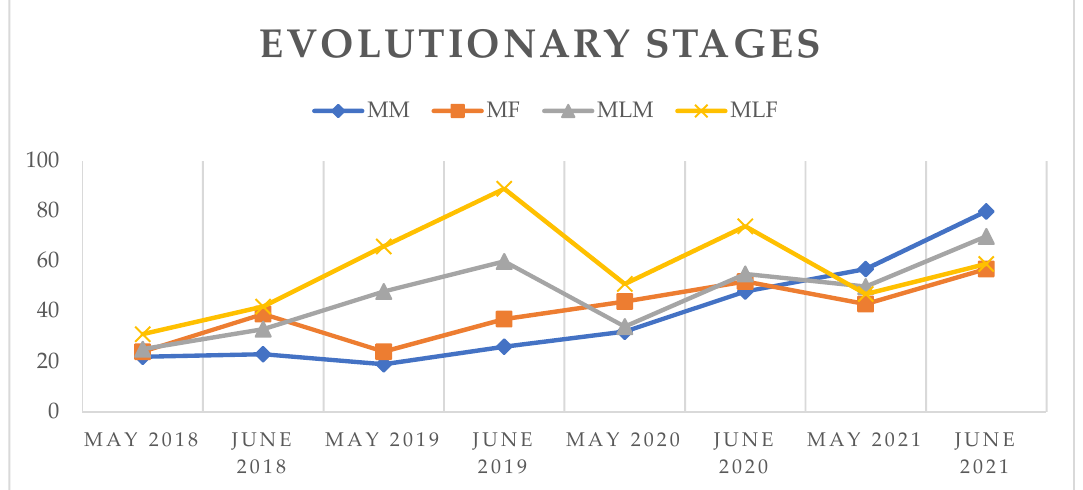
Figure 4. Evolutionary stages of Mentha x piperita L. and Melissa officinalis L. growth in common crops [23] compared with control ones during 2018–2021; Legend: MM–peppermint control crop; MF—peppermint phytosociological (common) crop; MLM—lemon balm control crop; and MLF—lemon balm phytosociological (common) crop; evolution of heights—y axis.